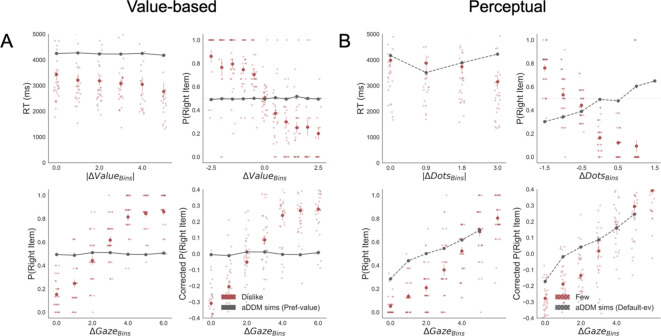
Replication of behavioural effects by aDDM simulations for dislike (A) and fewest frames (B).Importantly, these models were fitted using the default evidence in Value and Perceptual Experiments, that is, preference value and number of dots, respectively. Unlike the models fitted with goal-relevant evidence, these models do not capture reaction time (RT) and choice behaviour in dislike and fewest frames. The four panels present four relevant behavioural relationships found in the data. Top left: faster responses (shorter RT) when the choice is easier (i.e. easier choices are found with higher |ΔValue| and |ΔDots| in Value an Perceptual Experiments, respectively). Top right: probability of choosing the right alternative increases when the evidence towards the left item is higher (ΔValue and ΔDots are calculated considering right minus left options). Bottom left: the probability of choosing the item on the right side of the screen depends on the gaze time difference (ΔGaze, calculated as the time observing the right minus the left item). Bottom right: gaze influence on choice depending on the difference in ΔGaze (check Results section for more details on gaze influence). Solid red dots depict the mean of the data across participants in dislike and fewest frames. Light blue dots show the mean value for each participant. In Value Experiment, the solid grey lines show the average for model simulations. In the Perceptual Experiment, segmented grey lines show the average for model simulations. Data and simulations were binned for visualisation.